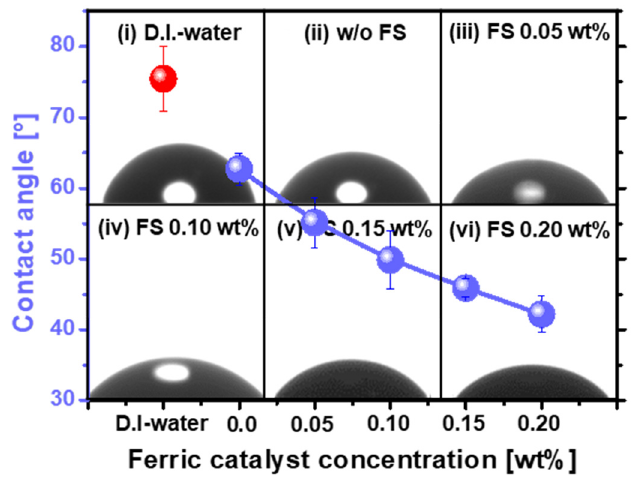
Figure 5. Adsorption degree (i.e., contact angle) of the SOC film surface CMP slurry on the polished SOC film surface, depending on the ferric catalyst (Fe 2 (SO 4 ) 3 H 2 O)) concentration. 3.4. C-C Bond Breakage Mechanism of the SOC Film Surface during CMP Using Ferric Catalyst (i.e., Fe 2 (SO 4 ) 3 )